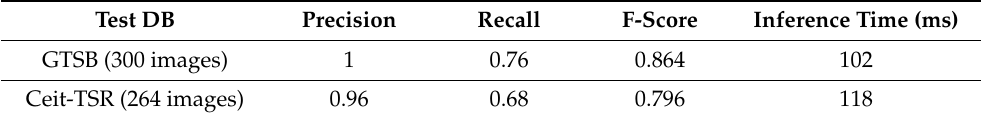
Table 4. Summary of detection results for the GTSB test set and Ceit-TSR dataset. Complex images made the model decrease its precision by 4% compared with the GTSB result.